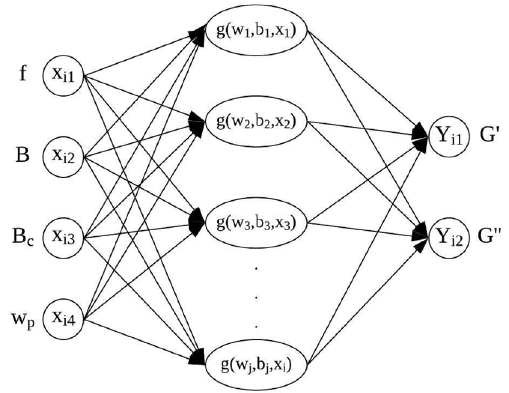
Figure 1. The SLFN structure for MR elastomer viscoelastic